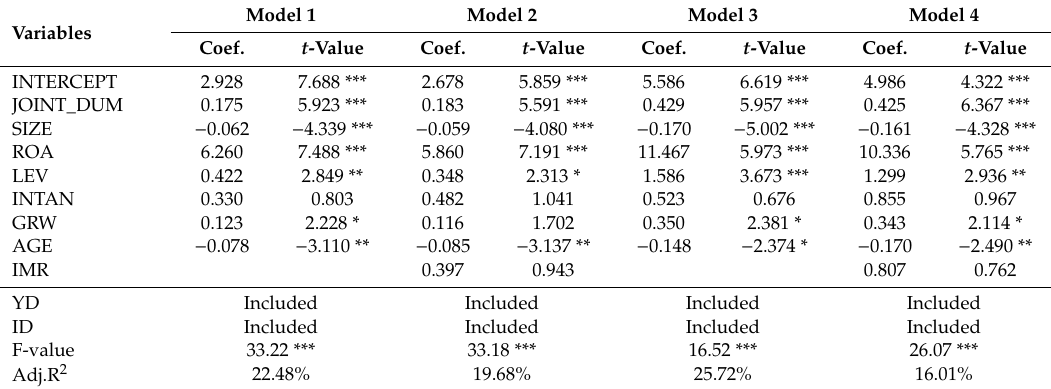
Table 7. Analysts’ cash flow forecasts issuance and firm